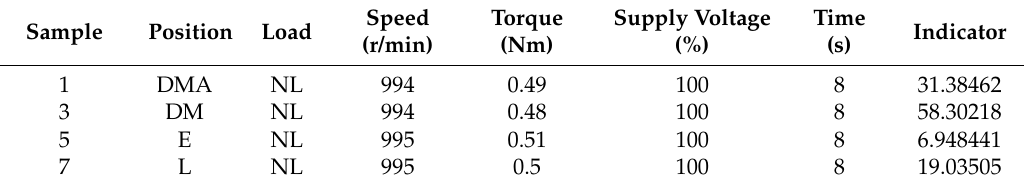
Table 12. Results of the indicator, based on Equations (6)–(8), for the data of the healthy motor experiments under the steady state regime.